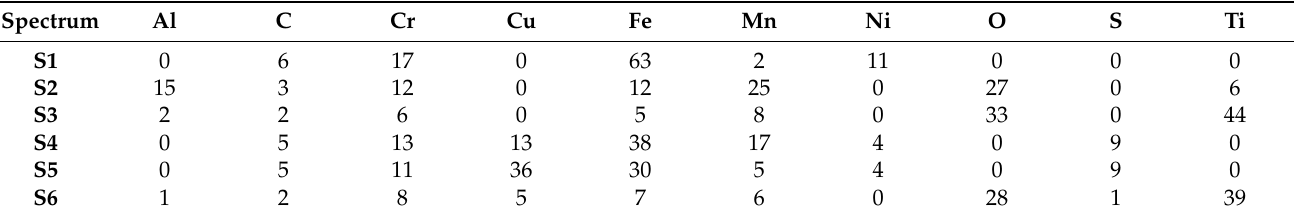
Table 3. Selected results of the EDS analysis of the points S1–S6 in Figure 7b, wt% assumed with relative scatter of ±